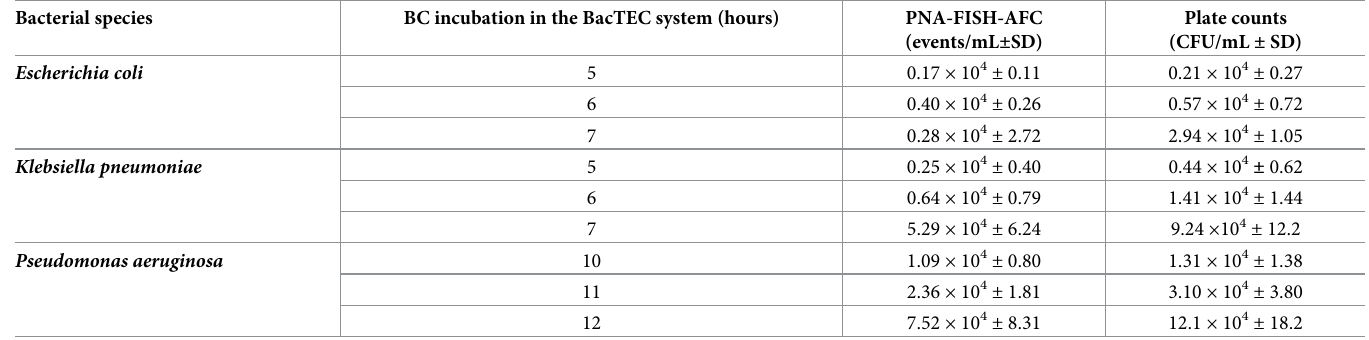
Table 4. Bacterial enumeration using PNA-FISH and plate counts at the time of detection. Bacterial species